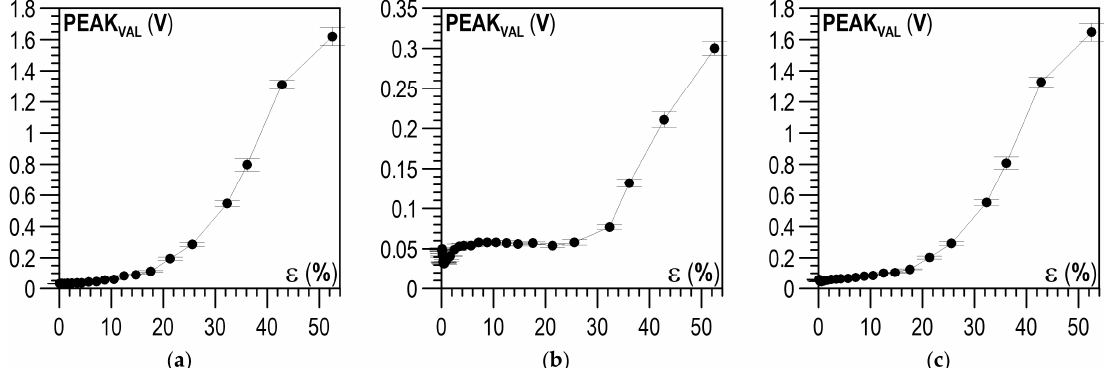
Figure 17. Relation between plastic deformation ε and mean PEAK VAL for ascending halves of magnetisation I ↗ : ( a ) parallel direction; ( b ) perpendicular direction; ( c ) module of directions.